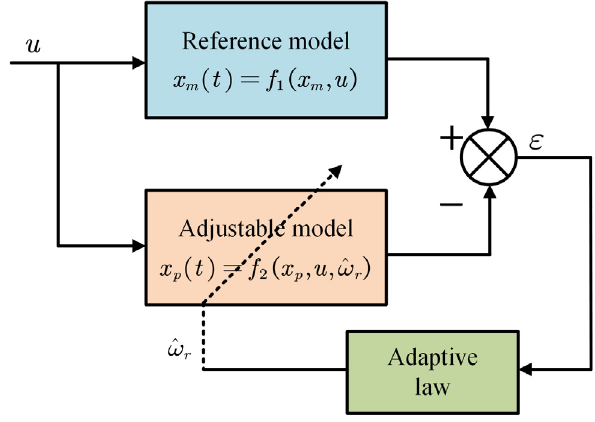
Figure 1. Block diagram of the speed-estimation-based MRAO.